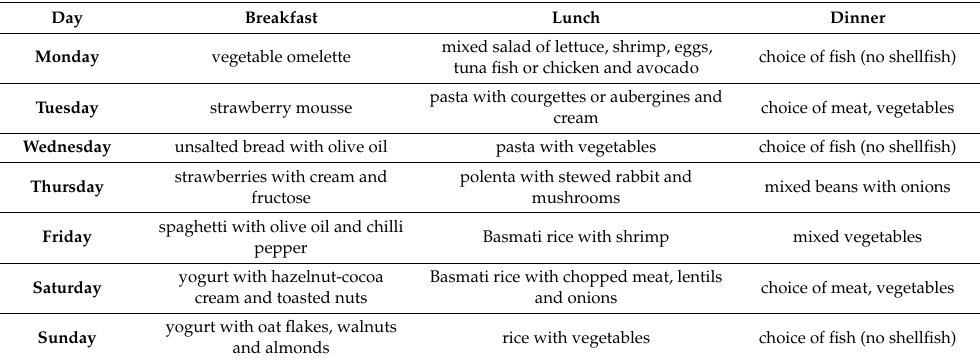
Table 2. Examples of menus in the weight-maintenance